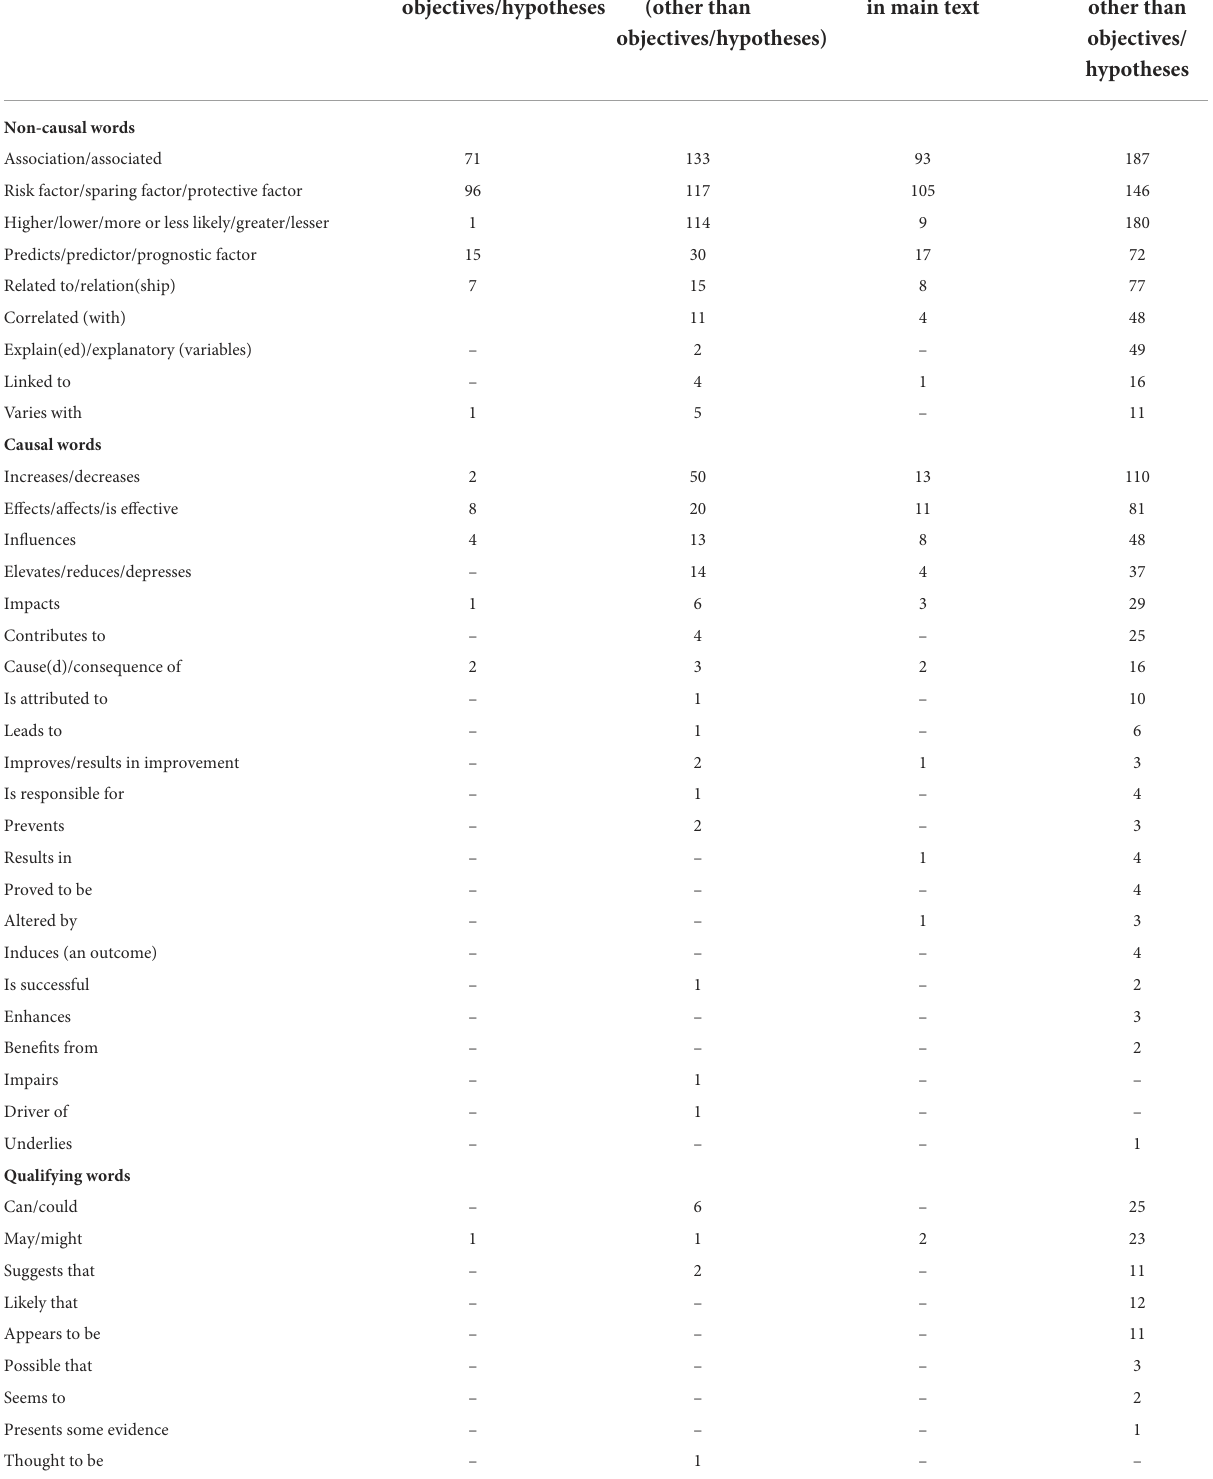
TABLE 4 Description of non-causal, causal, and qualifying words using in different article